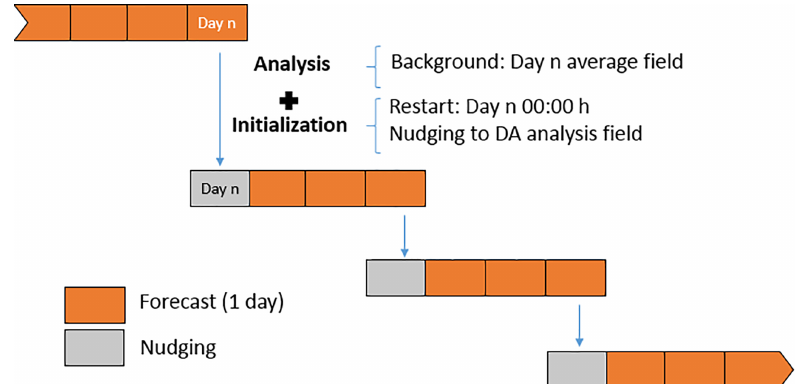
Figure 4. Scheme of the 3-day DA